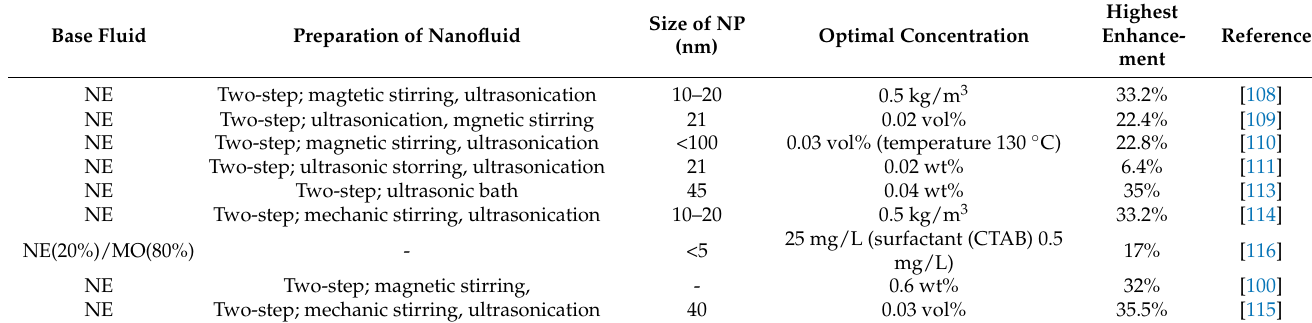
Table 6. TiO 2 AC-BDV overview table. The size of NP refers to the nanoparticle core size, while the optimal concentration indicates the concentration value for which the maximal enhancement of AC-BDV was